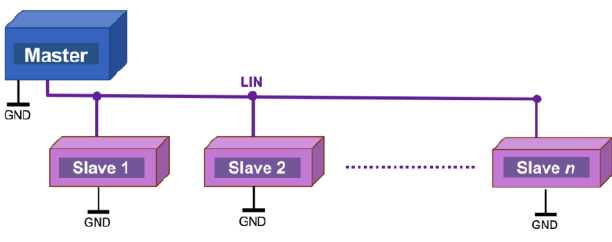
Figure 1. LIN topology, supporting up to 15 slave nodes.